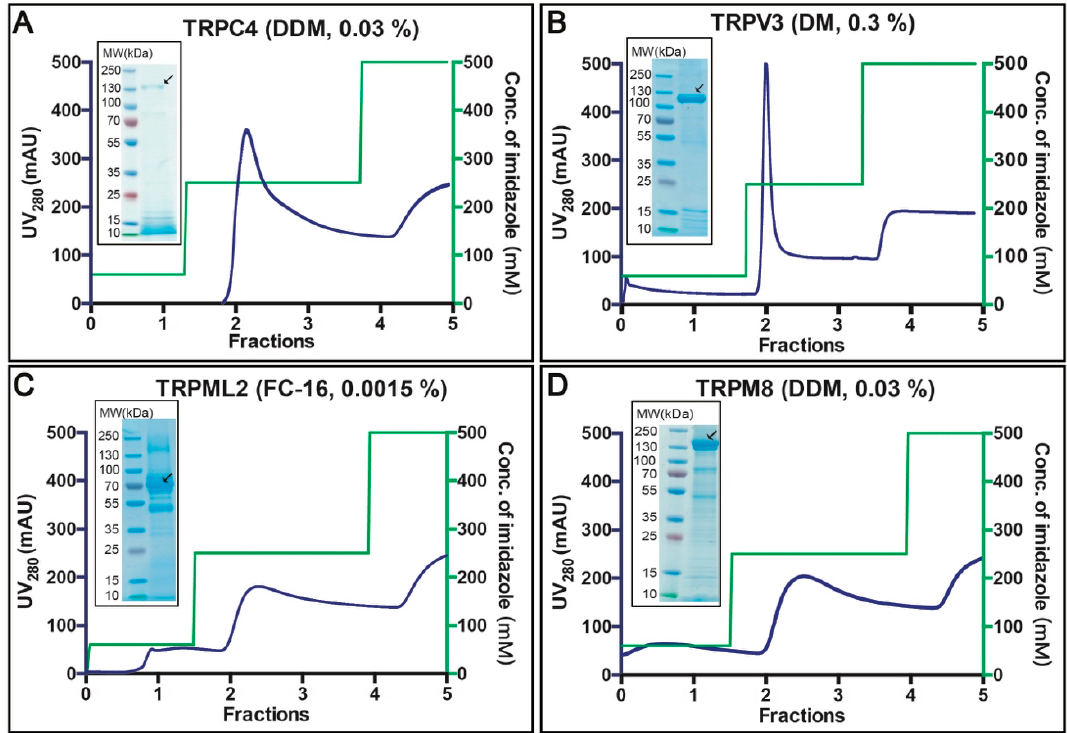
Figure 5. Purification of selected human TRP channels. ( A – D ) Selected targets were purified from crude S. cerevisiae membranes isolated from 40 g of fermenter-grown cells (obtained from ~3 L of cell culture) induced for 96 h at 15 °C. Membranes were solubilized with the indicated detergents for 3 h at 4 °C. Affinity protein purification was performed using immobilized metal ion affinity chromatography (IMAC). Concentrations of the corresponding detergents used for protein elution are indicated. IMAC profiles display UV 280 signal for eluted protein (blue) and the corresponding imidazole gradients used for elution (green). Insets: Coomassie-stained SDS-PAGE gels with concentrated affinity-purified samples. Black arrows indicate the MW for the corresponding fusion protein.